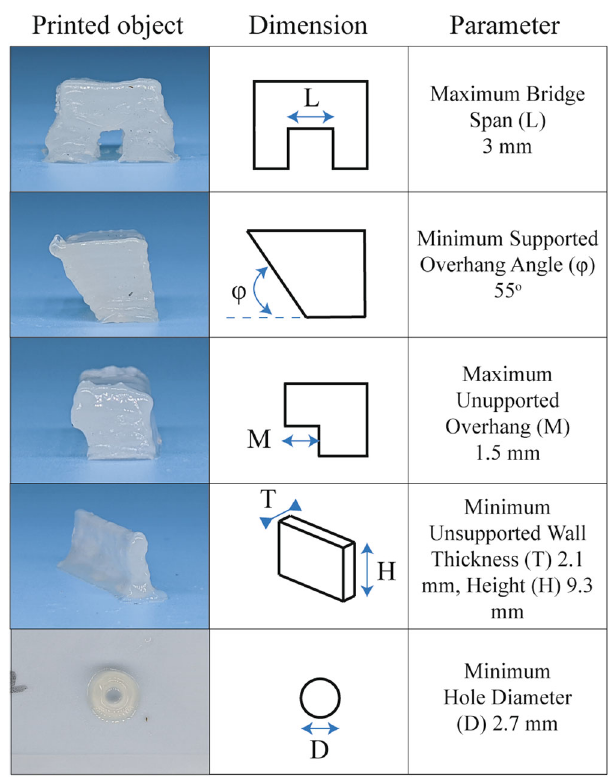
Fig. 7 Achievable design parameters for common building blocks in additive manufacturing. This fi gure presents: maximum bridge span, minimum supported overhang angle, maximum unsupported overhang, minimum unsupported wall thickness and height, and minimum hole